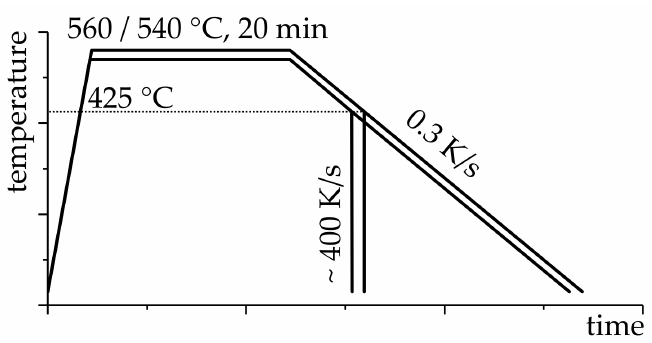
Figure 8. Schematic time–temperature profile of the heat treatments for the microstructure